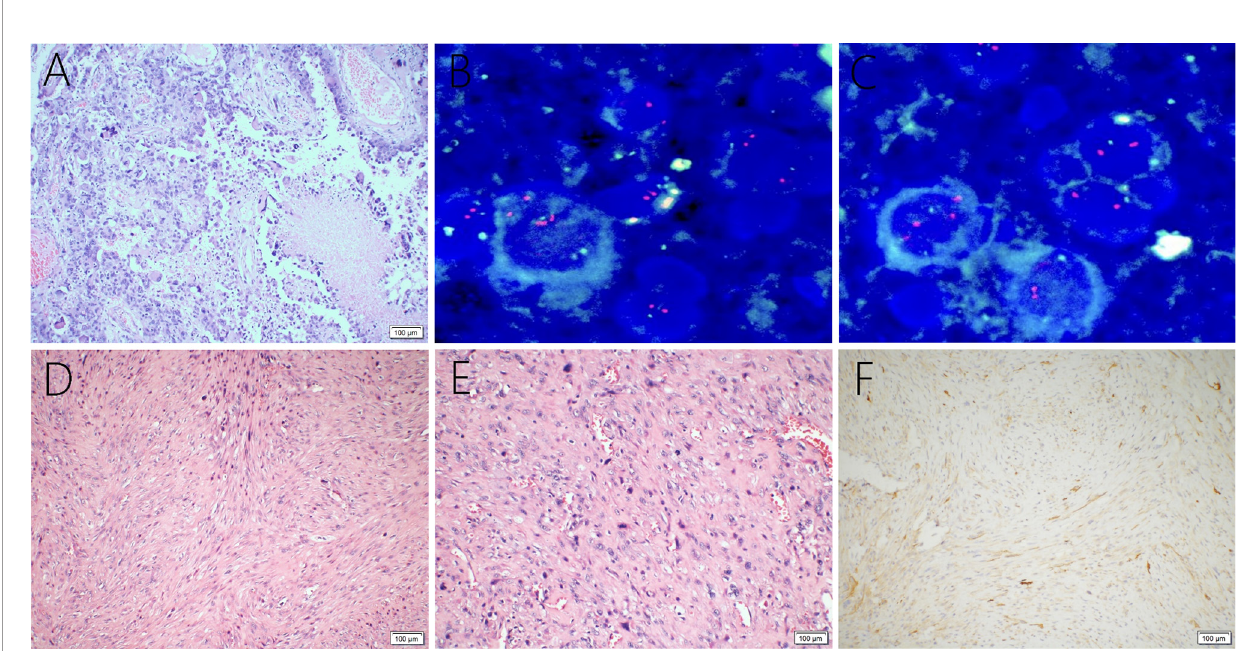
FIGURE 2 | Giant cell glioblastoma is composed of large, closely-arranged cells, with an eosinophilic cytoplasm and obvious nuclear atypia. There are also scattered multinucleated giant cells. Local necrosis and vascular proliferation are observed (A) . FISH detection suggests no loss of heterozygosity in 1p (B) or 19q (C) chromosomes. Primary intracranial leiomyosarcoma showing spindle − shaped cells (D) and abundant mitotic activity (E) through the tumor, hematoxylin, and eosin staining. Immunohistochemical examination was positive for H-caldesmon (F) .